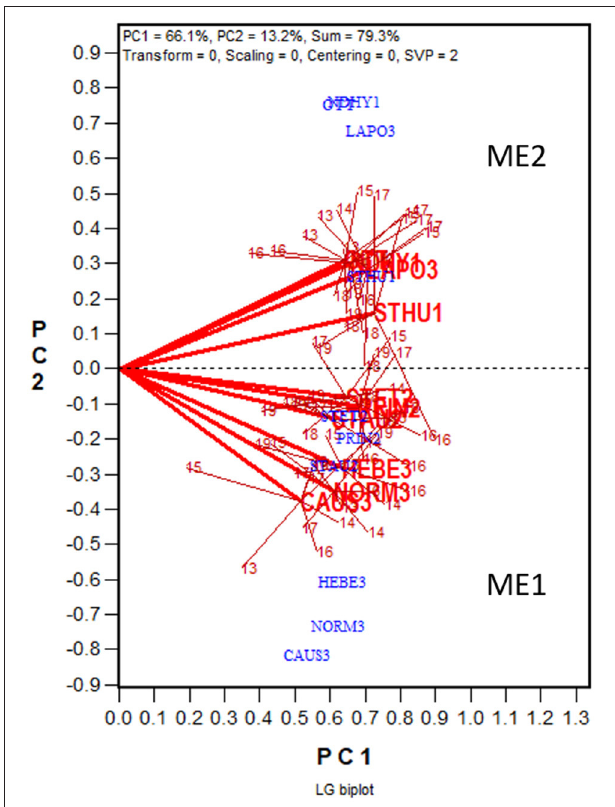
FIGURE 5 | LG biplot to show two oat mega-environments in Quebec. PC1 and PC2 are the first two principal components from singular value decomposition of the location by trial two-way table of correlations, without centering (“Centering 0”) or scaling (“Scaling 0”). The LG biplot is a = = location by trial biplot, with the locations presented in blue and the trials in red. The trials conducted at each location are presented as a cluster of trials, with the location name placed at the center and the individual trials, indicated by the last two digits of the year, placed around it. The trials are connected to the location with straight lines. Two locations are regarded as belonging to the same mega-environment (ME) if their clusters overlap; they are regarded as belonging to different mega-environments otherwise. The same two MEs (ME1 and ME2) shown in Figure 4 are shown in this LG biplot. The variation in the placement of the locations between mega-environments represents repeatable GE and the variation in the placement of the trials within mega-environments represents unrepeatable